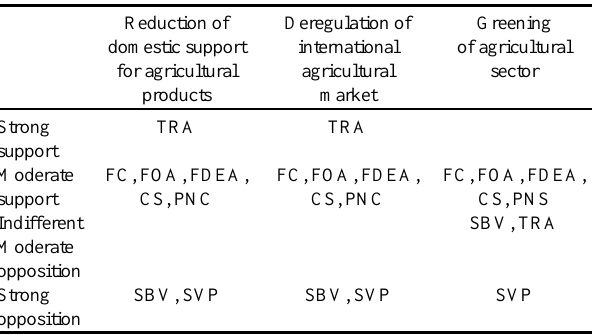
Table 5 . Policy positions of core